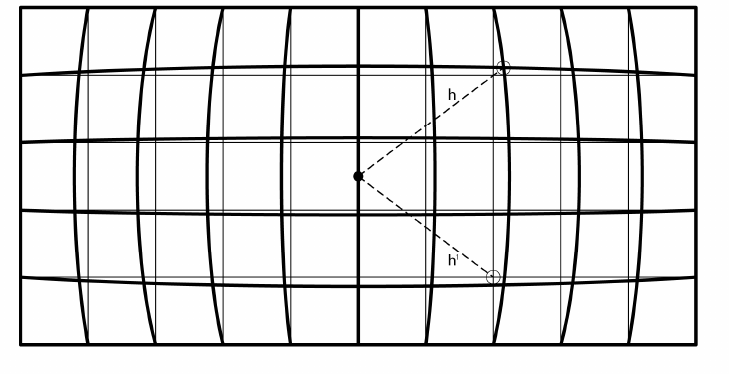
Figure 4. Barrel distortion. In barrel distortion, the image magnification decreases with distance from optical